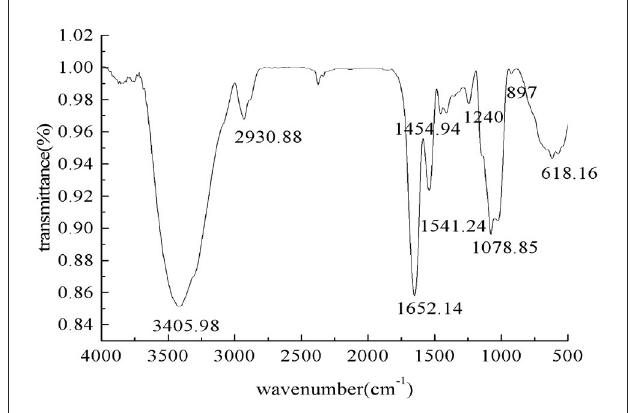
FIGURE2 The IR spectrum of the PEPs.